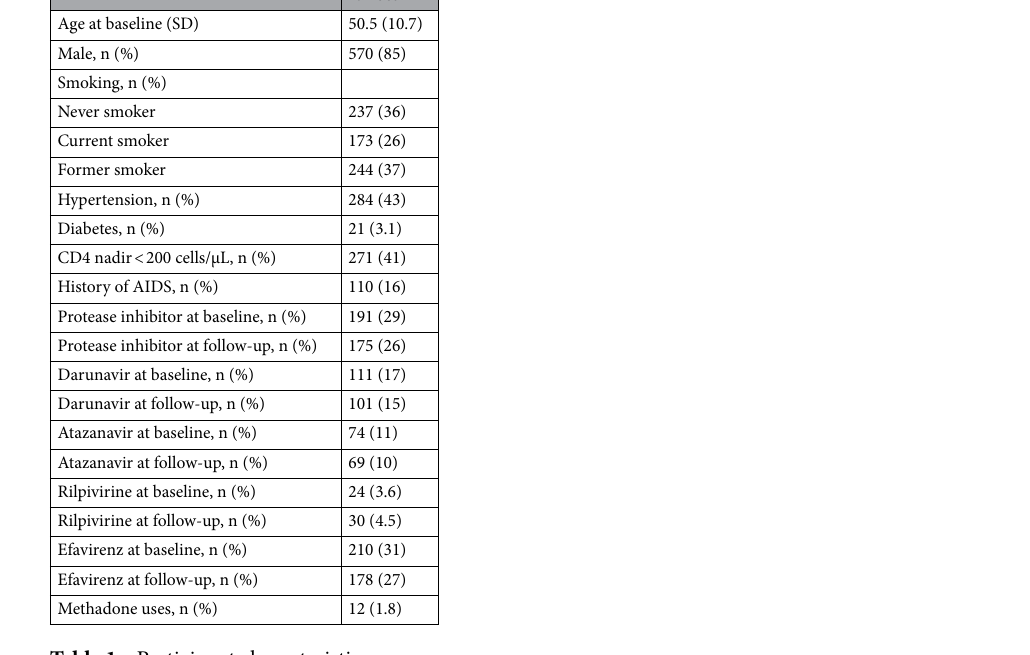
Table 1. Participant characteristics.